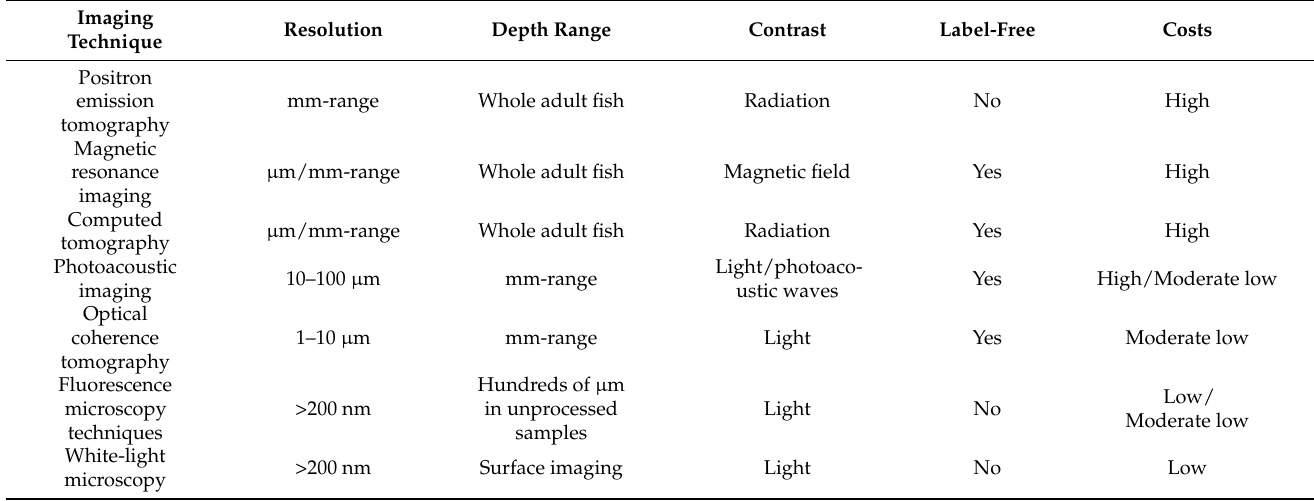
Table 1. Comparison of various imaging technologies and OCT used for in vivo zebrafish imaging. The resolution capability, the possible depth range, the contrast mechanism, if the technique is label-free and the costs involved are